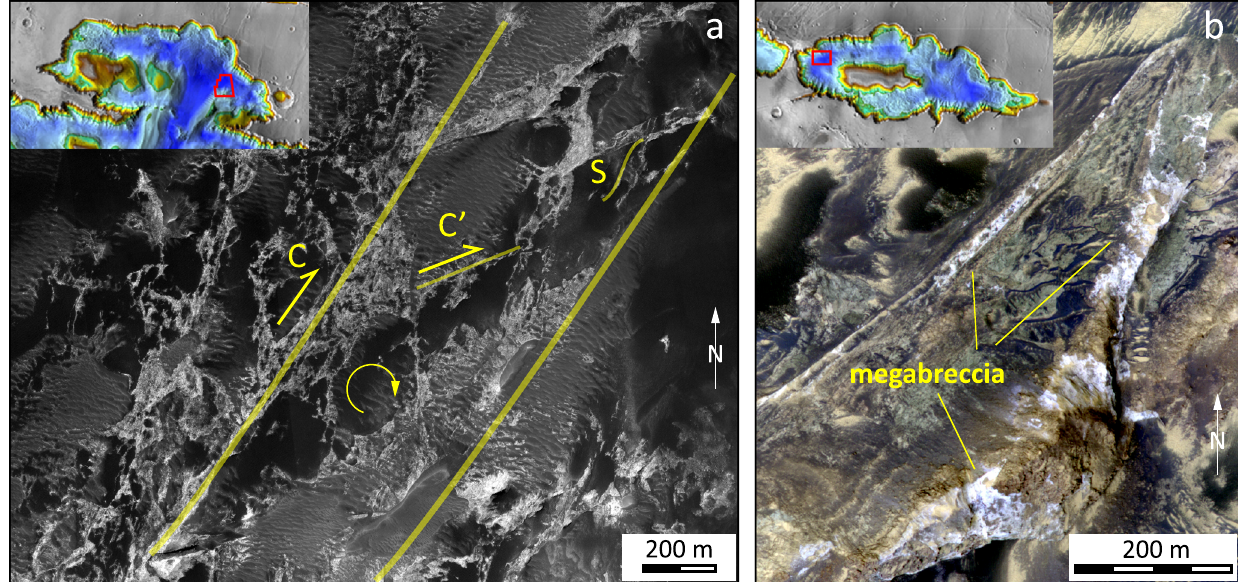
Fig. 3 Deformation patterns in the Ophir and Hebes shear zones. a Main exposure of the Ophir shear zone, highlighting S-C-C ’ structures indicative of brittle-ductile deformation (HiRISE image ESP_017754_1755). b Fault megabreccia exposed along the Hebes shear zone (HiRISE image ESP_040211_1790). Detailed structural mapping and context images are provided in Supplementary Figs. 1, 2. Credit: HiRISE images: NASA/JPL/the University of